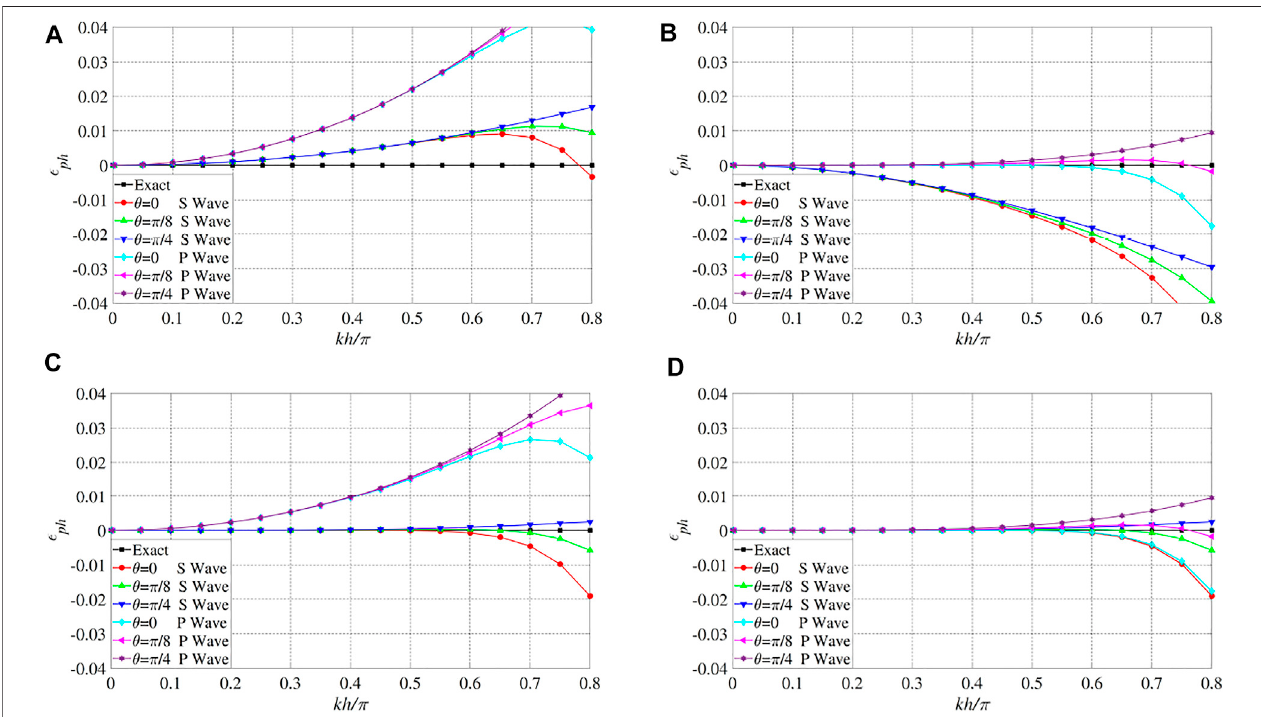
FIGURE5| P-wave and S-wavephase velocity dispersion curves ofthe elastic staggered-grid FDschemeswith r p (cid:2) 0 . 45 and r s (cid:2) 0 . 25. (A) C-SFD ( M =8) and (B) M-SFD ( M =8; N =1) with the FD coef fi cients calculated based on the P-wave time – space domain dispersion relation. (C) M-SFD ( M =8; N =1) with the FD coef fi cients calculated based on the S-wave time – space domain dispersion relation. (D) M-SFD ( M =8; N =1), the P-wave, and S-wave phase velocity dispersion curves are plotted with the FD coef fi cients calculated based on the P-wave and S-wave time – space domain relation, respectively.